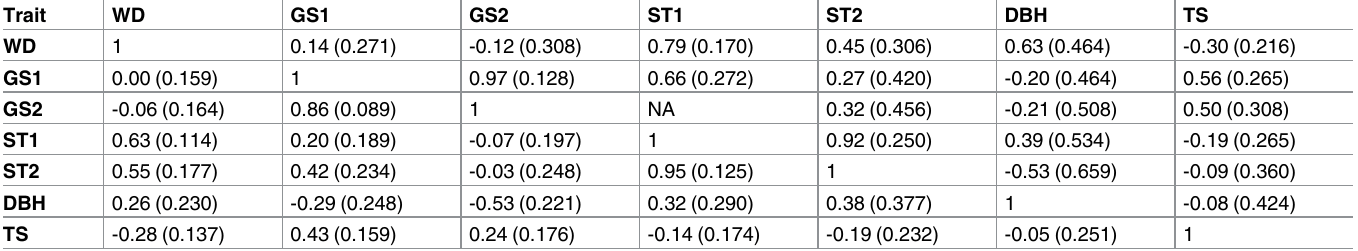
Table 3. Pairwise genetic correlations and their standard errors estimatedbased on information from pedigree (above diagonal) and from sib-ship reconstruction (below diagonal). Trait WD GS1 GS2 ST1